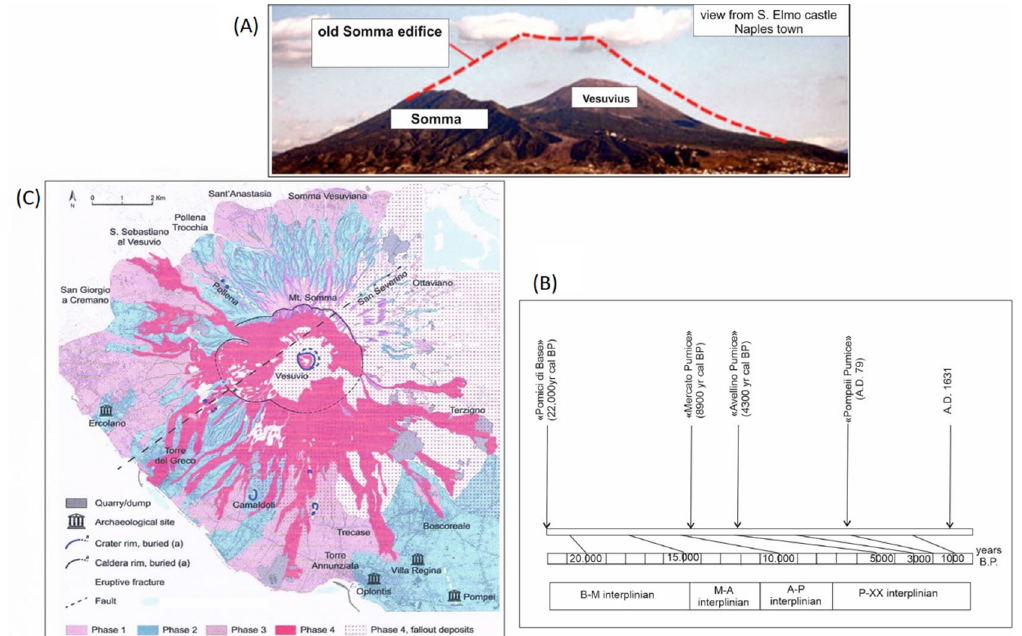
Figure 5. ( A ) Sketch reconstruction of the original profile of the old Somma volcano (modified after [74]); ( B ) Sketch diagram showing the eruptive history of the Somma ‐ Vesuvius (calibrated ages; modified after [73]). ( C ) Geologic map of the Somma ‐ Vesuvius (modified after [75]).